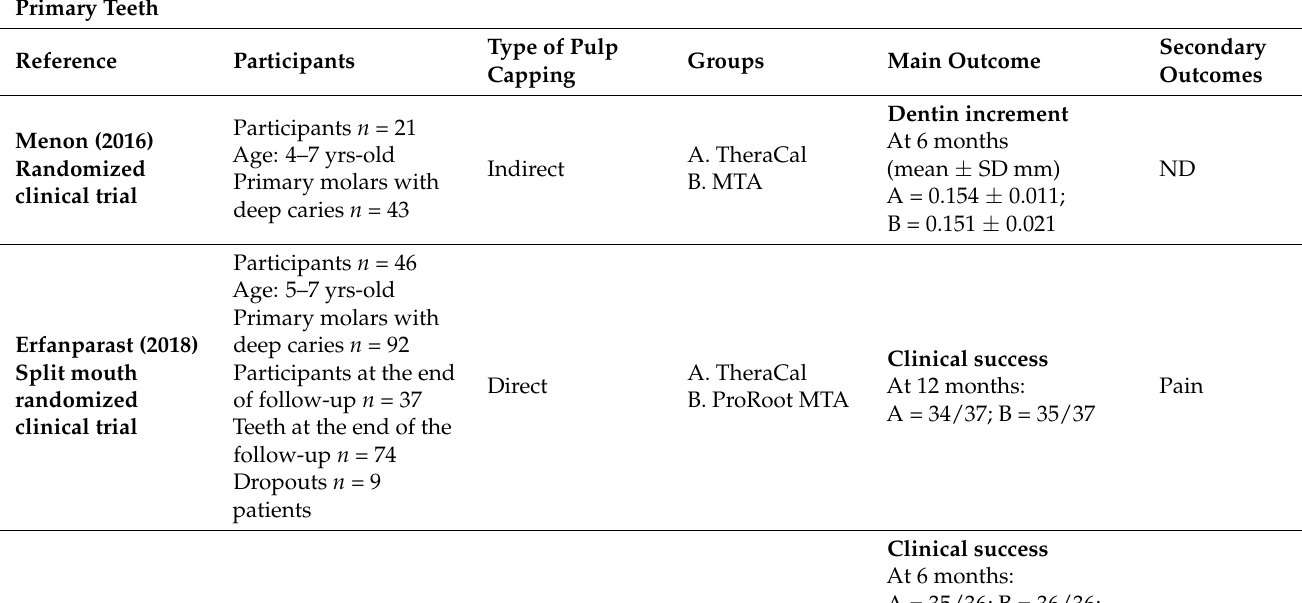
Table 3. Characteristics of the individual studies and their